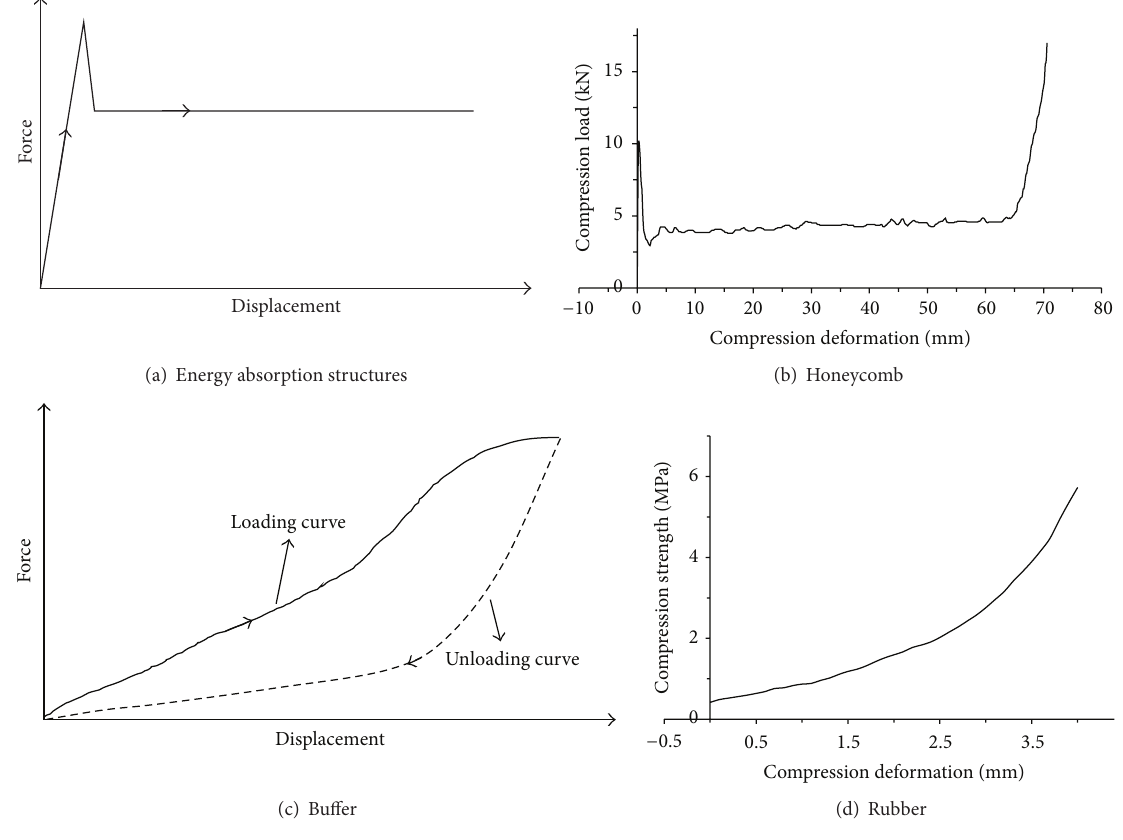
Figure 1: Mechanical property